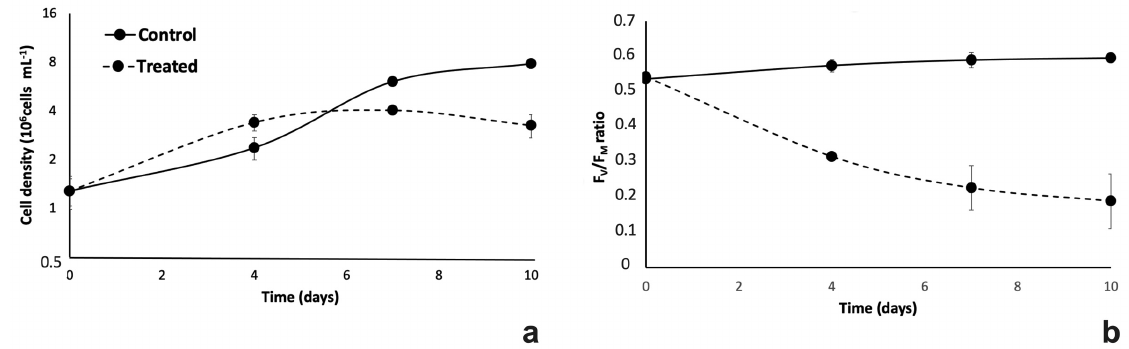
Figure 2. Growth kinetics ( a ) and photosystem II (PSII) maximum quantum yield ( F V / F M ratio) ( b ) of Chlorella sp. cells cultivated in modified synthetic BG11 medium (control samples; black line) and in 100% centrate (treated samples; dotted line). For growth kinetics, cell densities (10 6 cells mL − 1 ) are plotted on a base 2 logarithmic scale. For each sample, values are means ± standard deviations (s.d.; n = 3 for cell density; n = 6 for F V / F M ratio). In both cases, except for inoculation time (time 0), differences between control and treated samples were always significant (Student’s t test; p < 0.05).